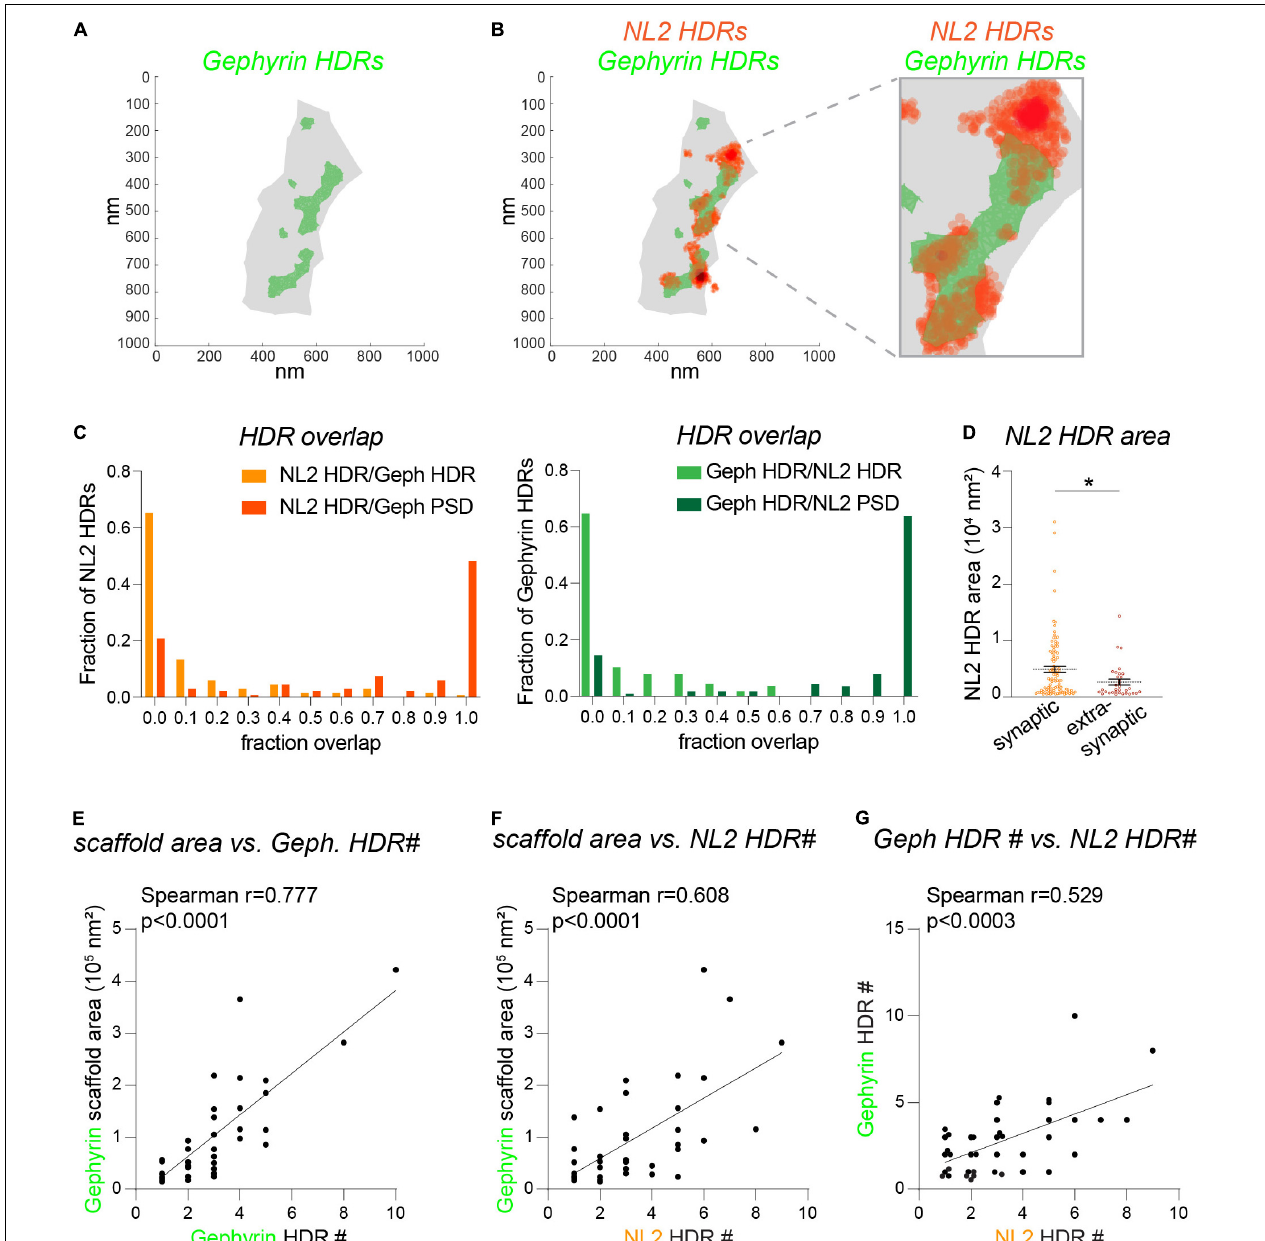
FIGURE 4 | Fine detail of NL2 and gephyrin subsynaptic structure analyzed by d STORM. (A) d STORM plots showing gephyrin scaffold boundary (gray) and boundaries for gephyrin HDRs (green). (B) d STORM plots showing gephyrin boundaries (green) with NL2 HDR localizations overlaid (orange). (C) Distribution histograms showing the relative proportion of NL2 or gephyrin HDRs with different degrees of fraction overlap with HDRs (lighter colors) or scaffold regions (darker colors). (D) Area distribution for synaptic and extra-synaptic NL2 HDRs. HDRs are considered synaptic with a 0.23 fraction overlap or greater with the gephyrin scaffold. Horizontal line denotes mean. * p = 0.016 (Mann Whitney), n = 33–102 HDRs. (E–G) Correlation plots showing the liner relationship between the gephyrin scaffold area and the number of gephyrin HDRs (E) and the number of NL2 HDRs (F) . As a result, there is a corresponding correlation between the number of gephyrin HDRs and the number of NL2 HDRs (G)